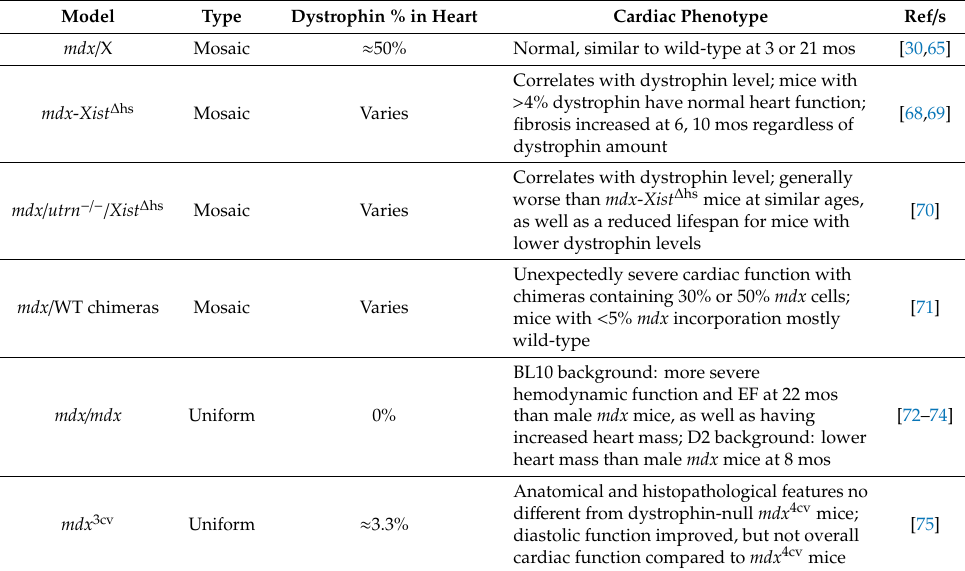
Table 1. Mouse models of female dystrophin mutation